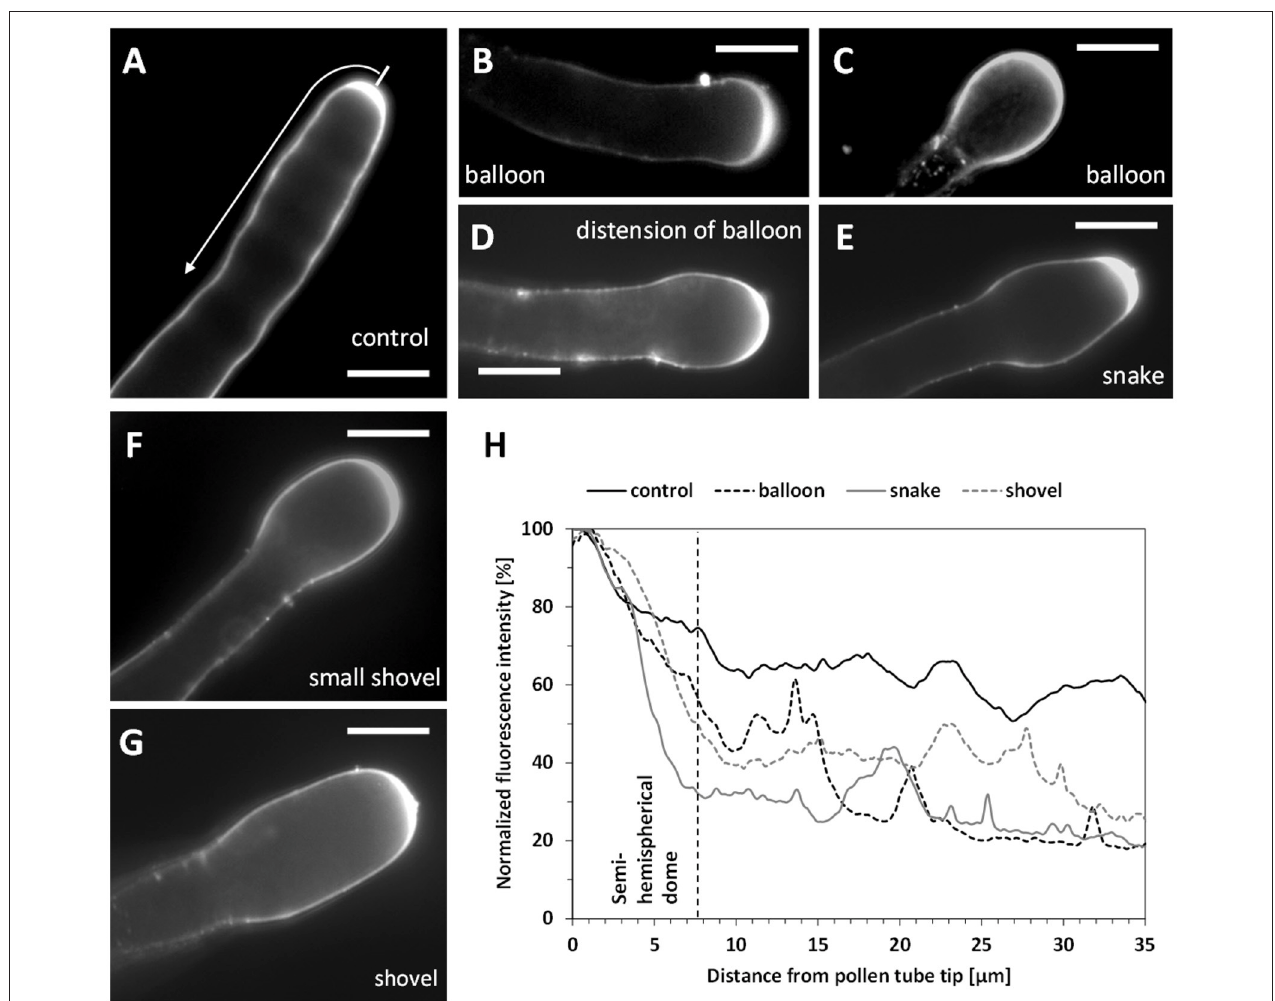
FIGURE 9 | Pectin distribution in control and Spm-treated pear pollen tubes. (A) Distribution of PI-stained cell wall polysaccharides in control pollen tubes. Arrow indicates the surface analyzed for PI fluorescence intensity. (B,C) Balloon stage. (D) A pollen tube resuming growth and switching from the balloon to the snake stage. (E) A typical example of a snake-shaped pollen tube. (F–G) Initial stage of shovel formation and a mature shovel-shaped pollen tube, in which PI-labeled pectins accumulate again in the tip. Bars for all pictures: 10 µ m. (H) Relative quantitation of PI fluorescence intensity in pollen tubes treated with Spm. The intensity profile is reported as relative fluorescence intensity starting from the tip. The analyzed half curvature of the pollen tube apex is called a “semi-hemispherical dome.” Graphs are calculated for the main steps of Spm treatment as indicated by the graph legend. Data are representative of three independent